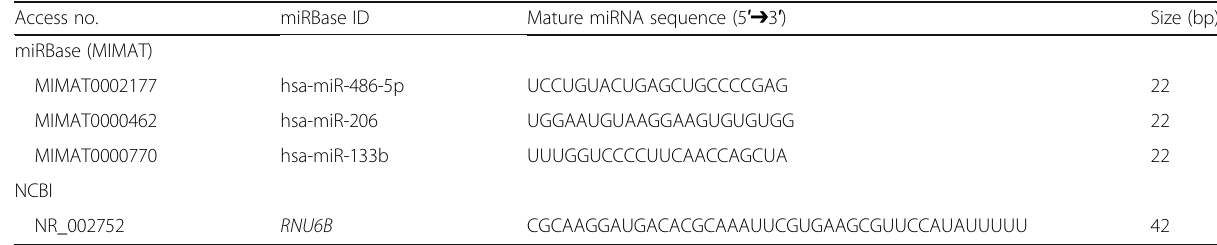
Table 1 Primer sequences of validated miRNAs Access no.